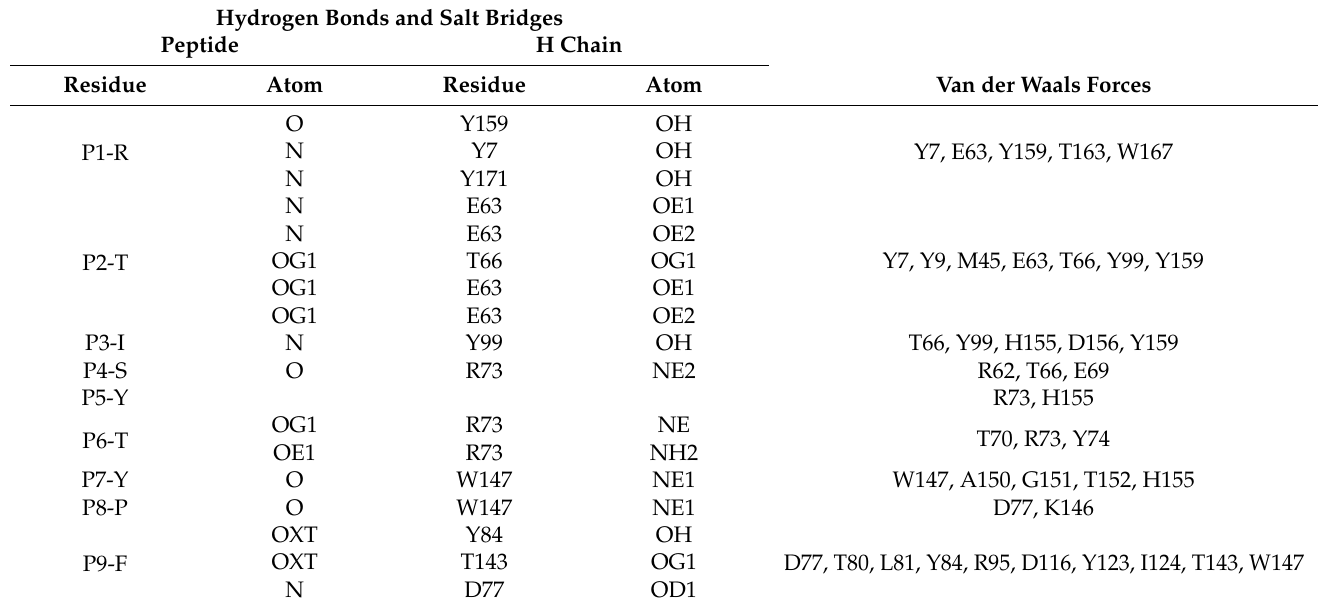
Table 2. The interactions between peptide RTI9 and DLA-88*001:04